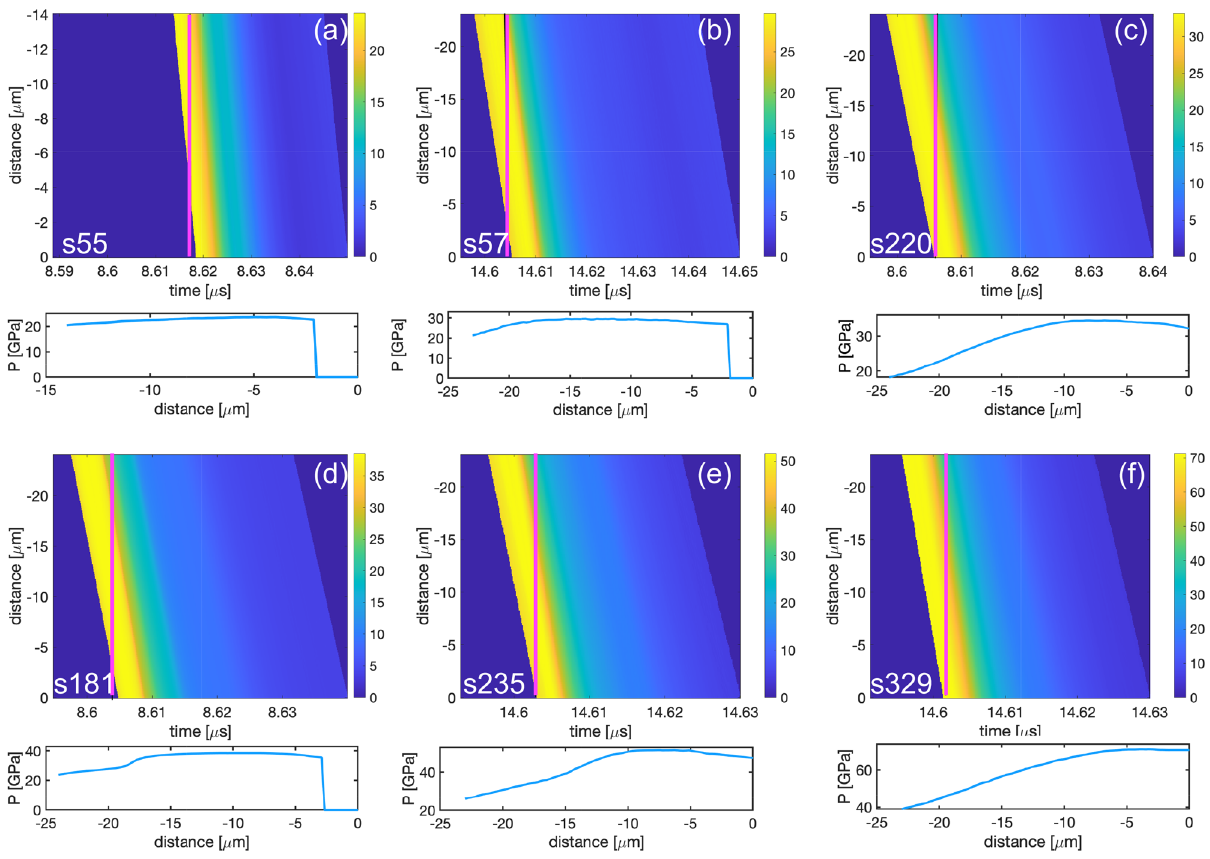
Figure 12. x-t diagram for selected shots showing the pressure variation across the sample for 15 and 25 µ m thick samples. Magenta line represents the time x-ray diffraction was collected. Bottom panel shows the pressure gradient across the sample position at the time of x-ray